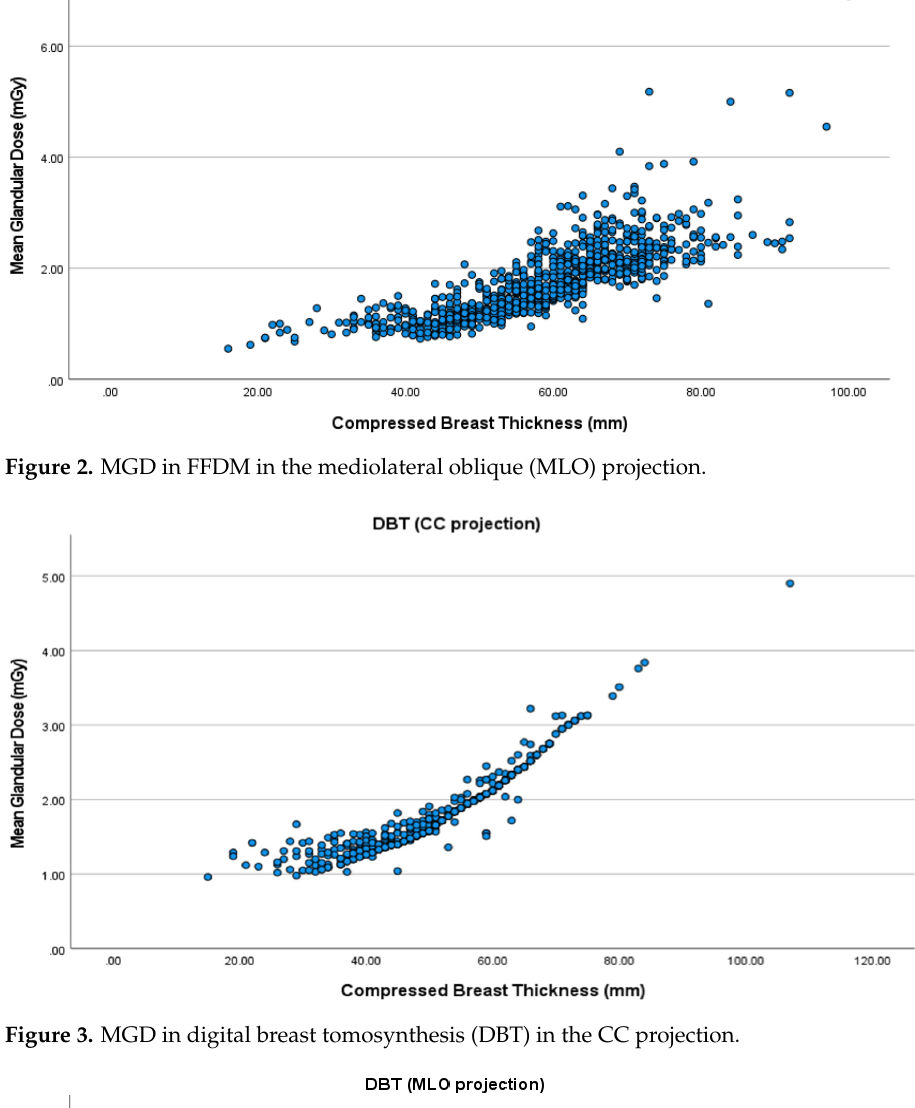
Figure 3. MGD in digital breast tomosynthesis (DBT) in the CC projection.